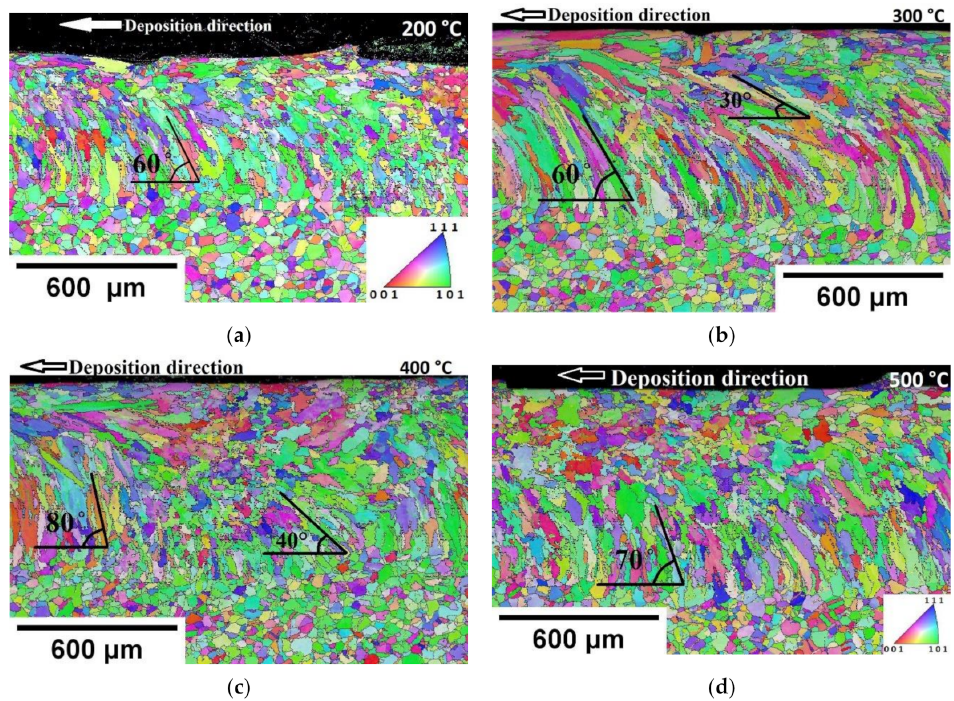
Figure 11. EBSD maps for preheating base plate single track longitudinal section. IPF colored orientation image map of preheating temperature ( a ) 200 ◦ C ( b ) 300 ◦ C ( c ) 400 ◦ C ( d ) 500 ◦